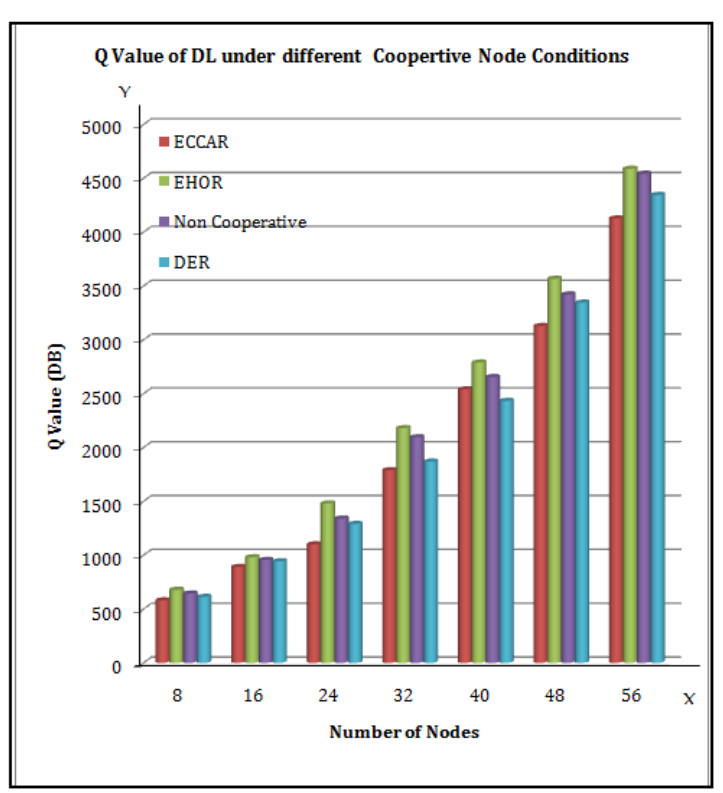
Figure 7. Q Value of DL under different Cooperative node conditions.